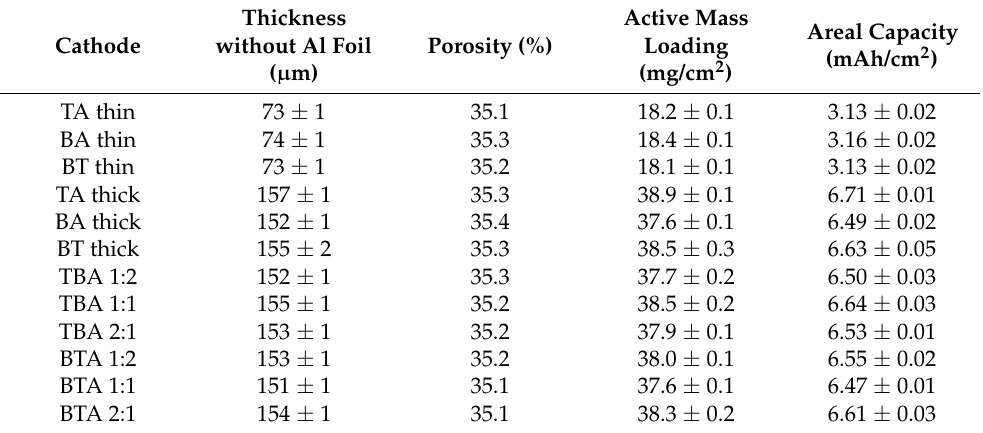
Table 1. The thickness, porosity, active mass loading, and areal capacity of electrodes consisted of different NMC 622 powder and with different multilayer structures. Thickness Cathode